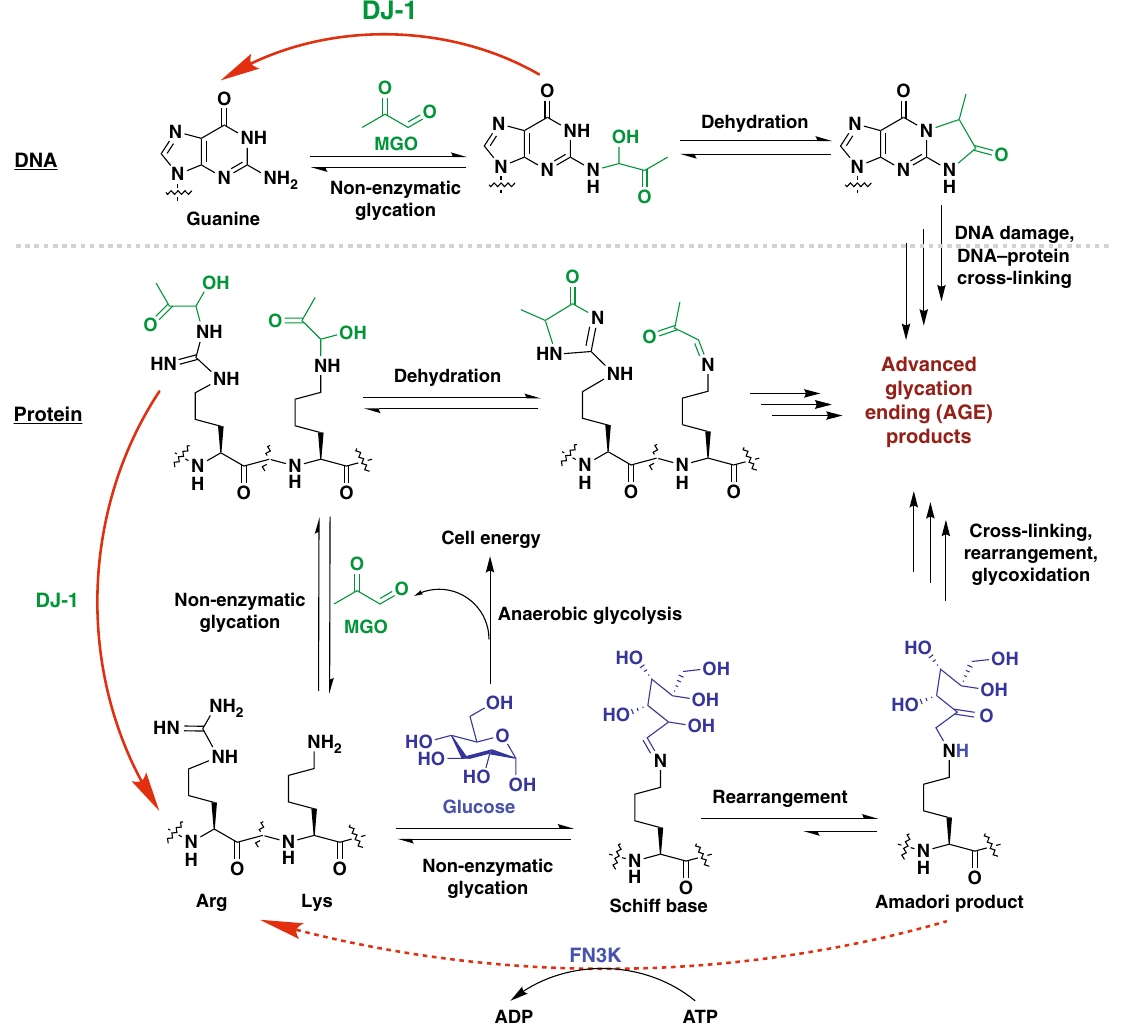
Fig. 1 Protein and DNA glycation and deglycation cycle. Schematics of DNA (top) and protein (bottom) glycation by sugars (e.g. glucose) or glycolysis by- products (e.g. methylglyoxal) and deglycation by the enzymes DJ-1 and